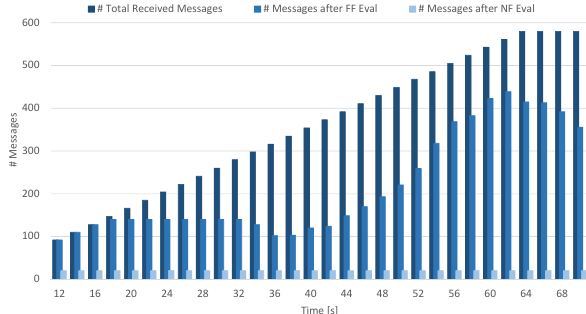
Figure 7: Position of the leading vehicle and CACC controlled local vehicle